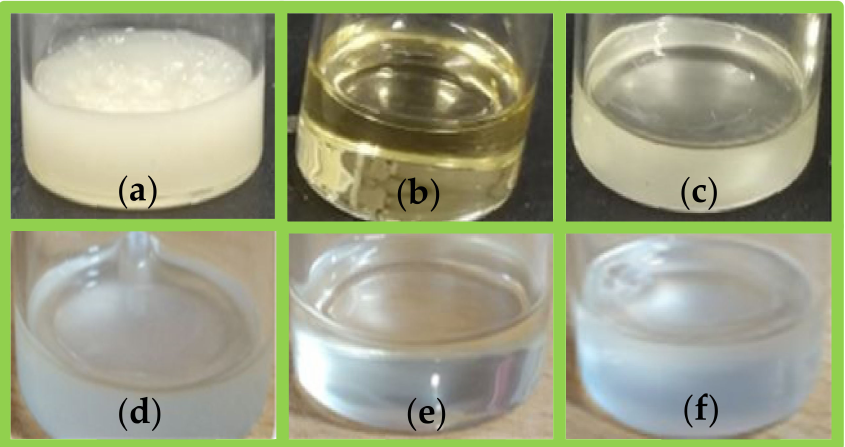
Figure 1. Binder sample photographs according to formulations: ( a , b ) using AGE or BMA based on